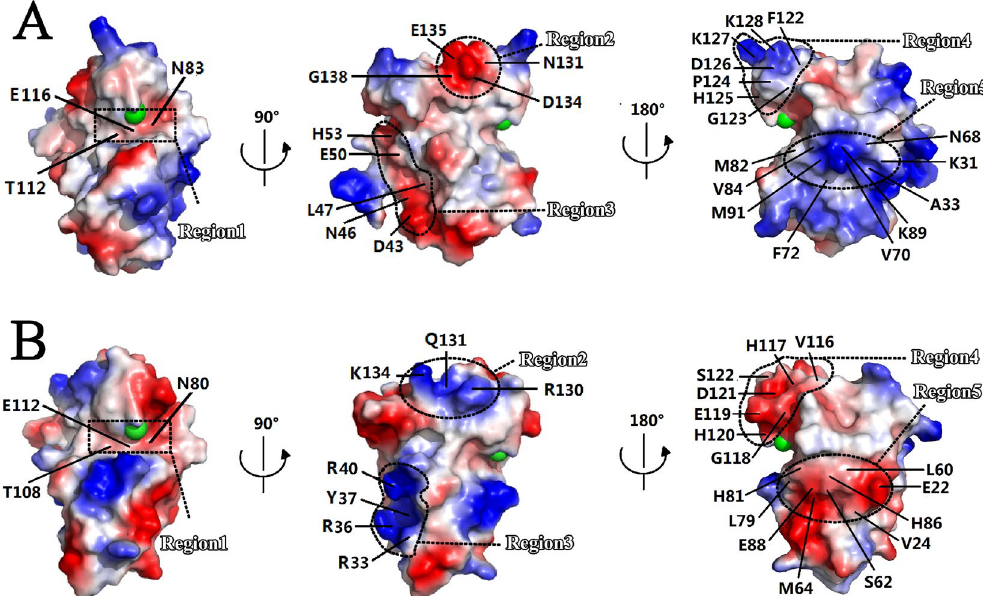
Figure 6. Molecular surface representations of ScWss1 21-148 (PDB: 5XBN) and SpWss1 17-151 (PDB: 5JIG) colored by their local electrostatic potential (blue, + 7.1KT; red, − 7.1KT). ( A ) Electronic surface potential distribution of ScWss1 21-148 from the side (first panel), front (second panel), and back (third panel) orientations, respectively. ( B ) Electronic surface potential distributions of SpWss1 17-151 from the same orientations as in Fig. 6A. The zinc ion is shown in green sphere in the